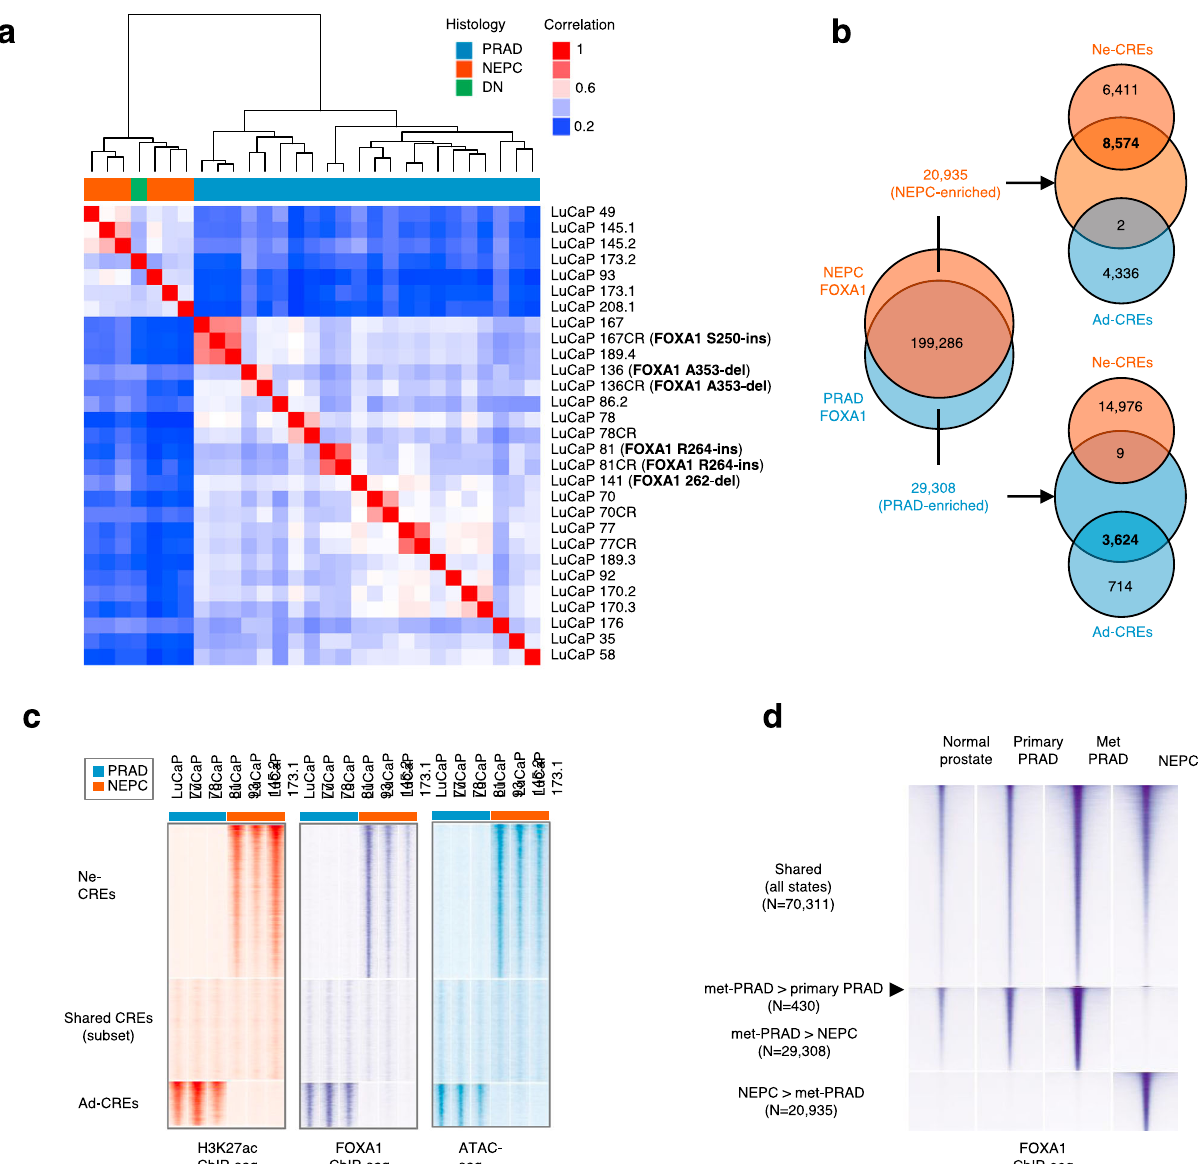
Fig. 3 Reprogramming of the FOXA1 cistrome in NEPC. a Hierarchical clustering of LuCaP PDXs by FOXA1-binding pro fi les. “ DN ” ( “ double-negative ” ) indicates a PDX without AR or NE marker expression. FOXA1 mutational status is noted; see also Supplementary Table 3). b Venn diagram of lineage- enriched and shared FOXA1-binding sites and their overlap with lineage-enriched candidate regulatory elements (Ad-CREs and Ne-CREs). Differential FOXA1 peaks were identi fi ed from n = 5 NEPC and n = 11 PRAD PDXs. c Normalized tag densities for H3K27ac/FOXA1 ChIP-seq and ATAC-seq at Ne- CREs and Ad-CREs. Three representative NEPC and PRAD PDXs are shown. d Average normalized tag densities for FOXA1 in normal prostate, primary PRAD, and PDXs derived from PRAD metastases (Met PRAD) or NEPC ( fi ve samples in each category) at differential FOXA1-binding sites between these groups. There are insuf fi cient differential sites to display (<100) for the Primary PRAD > Met PRAD comparison and the Primary PRAD vs. Normal prostate